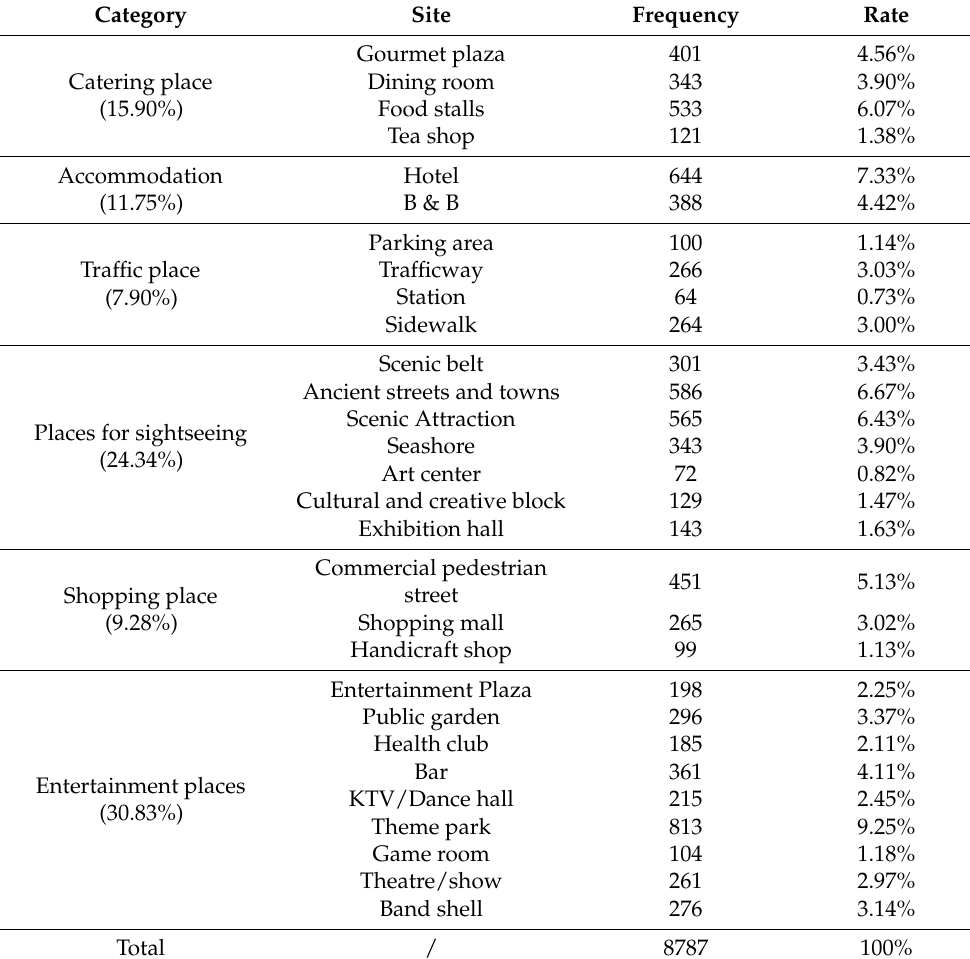
Table 3. Statistics of accident sites in night tourism of the